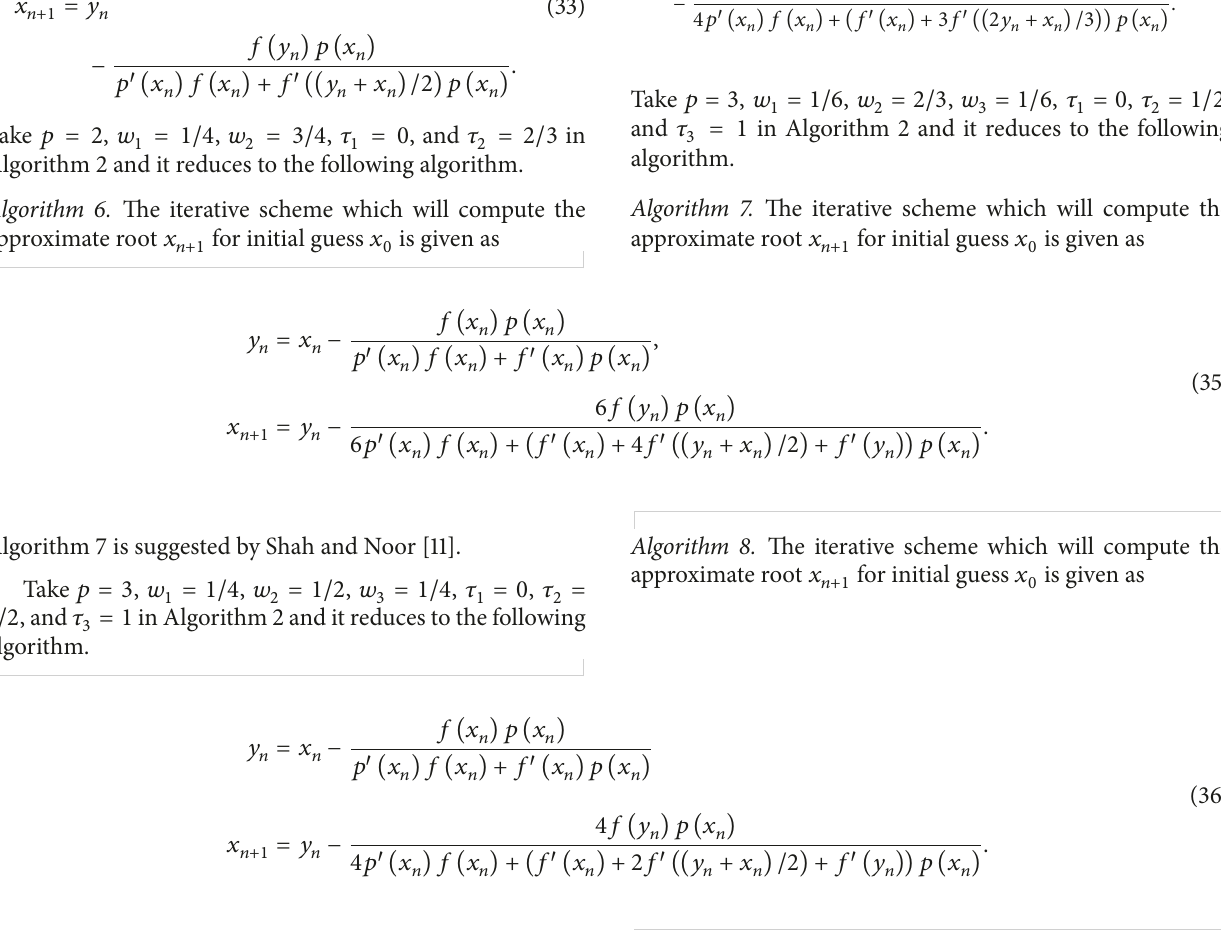
Algorithm 10. The iterative scheme which will compute the